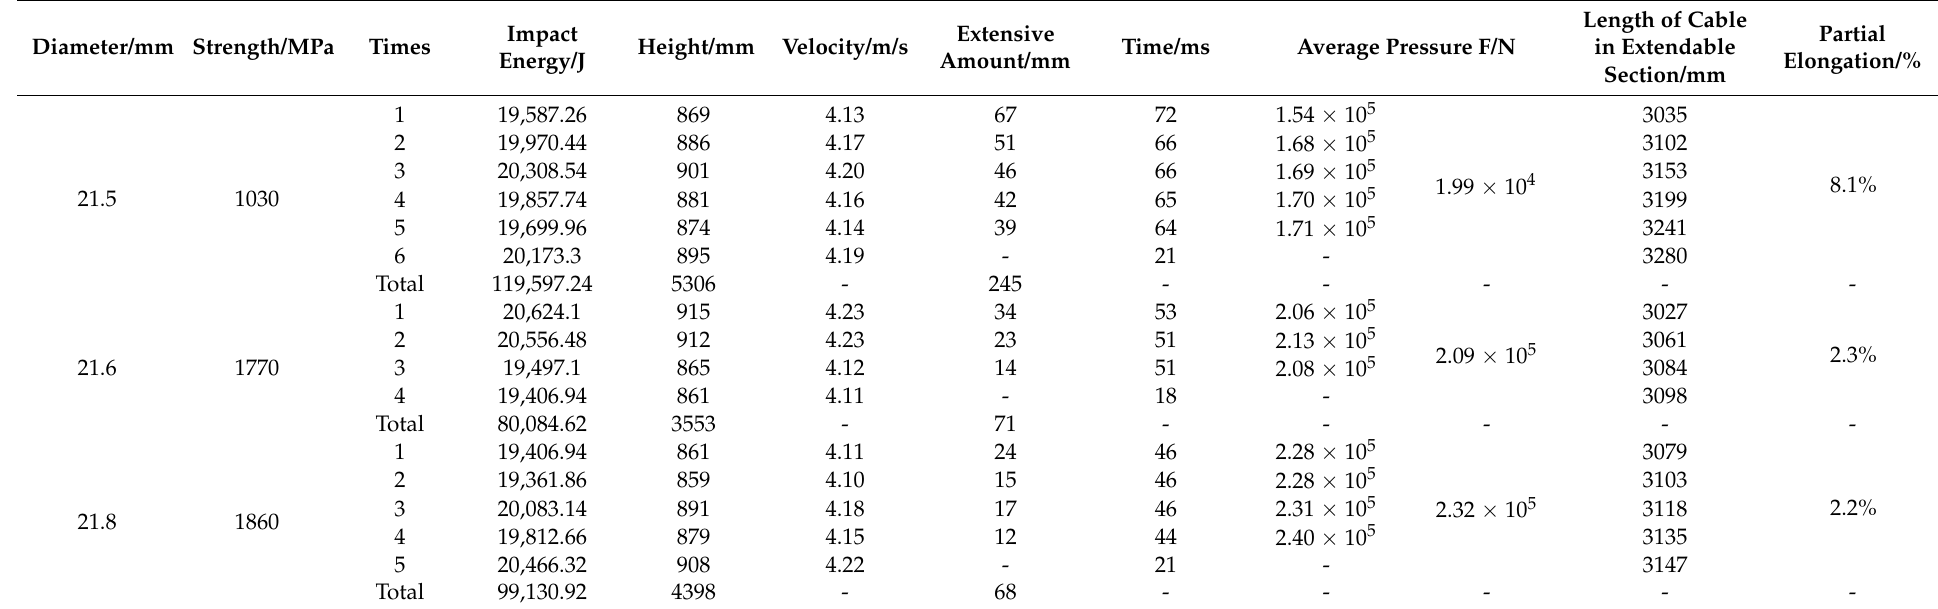
Table 2. Test data of impact resistance of different types of